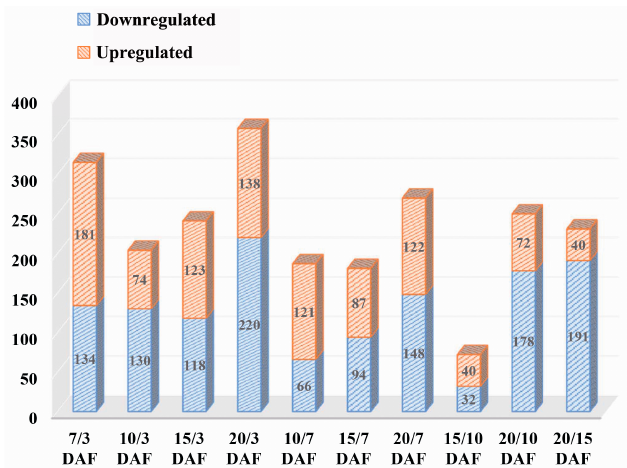
Figure 1. Distribution map of several differentially expressed proteins. A total of 848 proteins with a significant difference between any two time points were detected. The comparison between 20 DAF (day after flowering ) and 3 DAF yielded the most differentially expressed proteins (358), including 138 up-regulated proteins and 220 down-regulated proteins, followed by the comparison between 7 DAF and 3 DAF and the comparison between 20 DAF and 7 DAF. The comparison between 15 DAF and 10 DAF had the least amount of differentially expressed proteins (72), including 40 up-regulated and 32 down-regulated proteins. The X axis represents the comparison between different time points, while the Y axis represents the number of differentially expressed proteins.